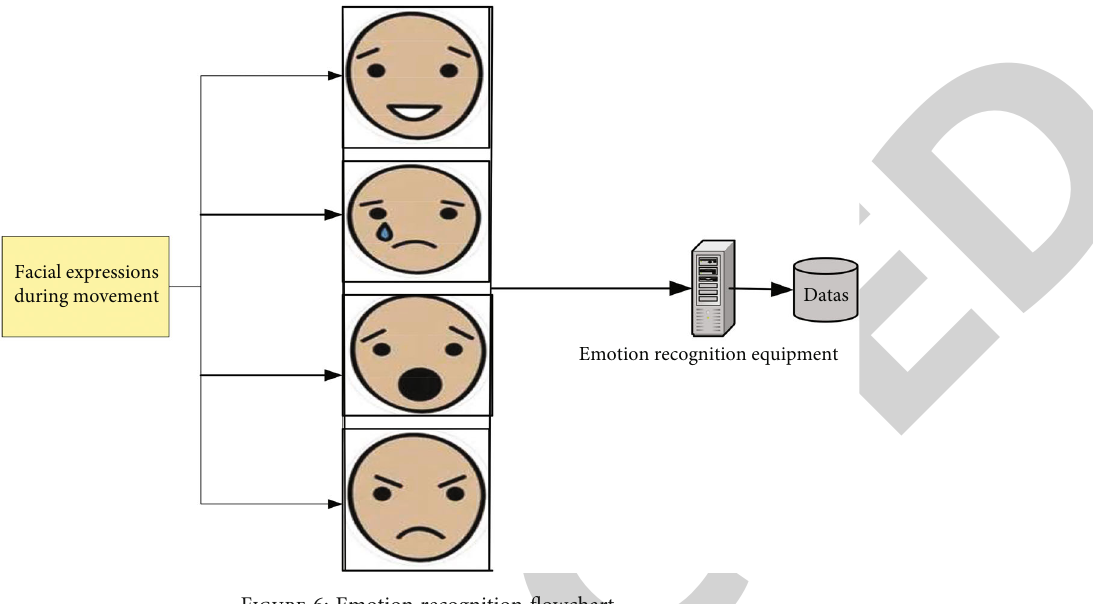
Figure 6: Emotion recognition fl owchart. Table 1: Physical fi tness test data